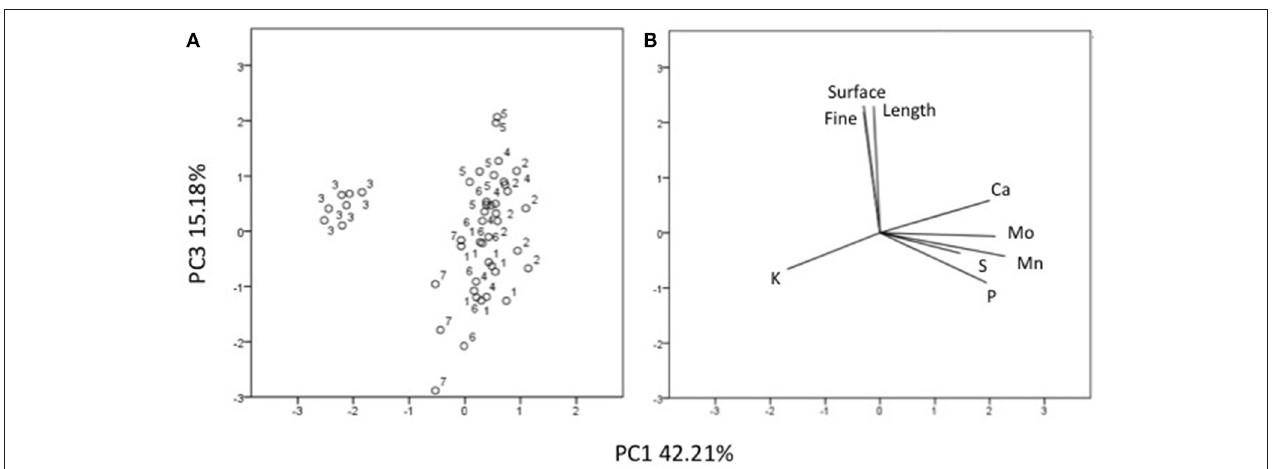
FIGURE 6 | Position of the samples representative of maize plants untreated and treated with seaweed extracts (A) and of the variables (B) projected in the plane determined by the axis 1 with axis 3 of the PCA. Seaweed extracts correspond to the circle number A = 1, B = 2, C = 3, D = 4, E = 5, F = 6, and untreated plants = 7. Length = root length, surface = root surface area, fine = root fine